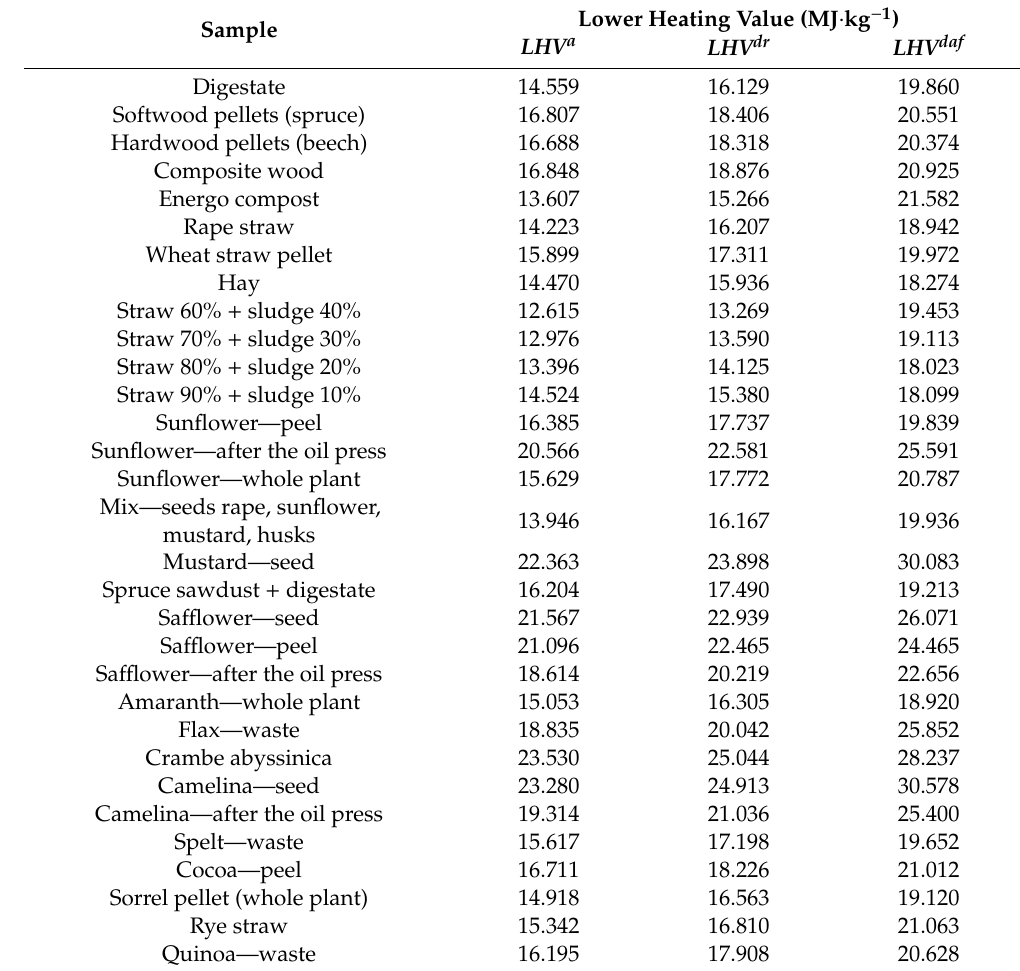
Table 10. Calculated lower heating values of analyzed